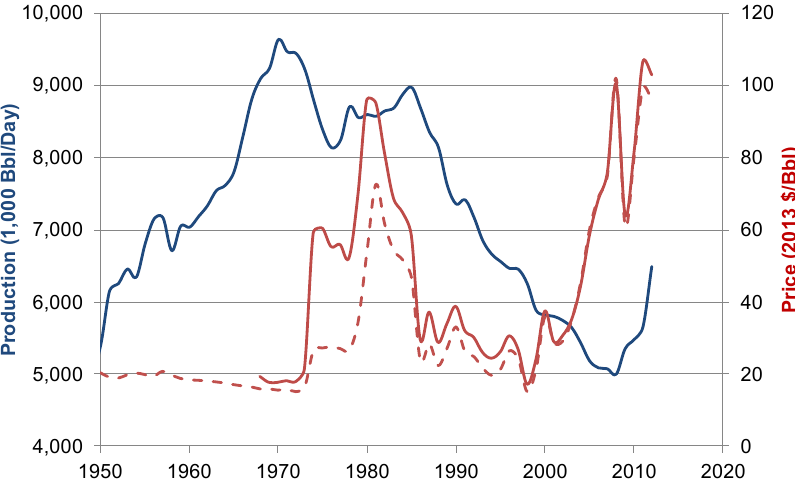
Figure 9. U.S. oil production and price, 1950–2012. Sources: [64] for prices; [65] for production